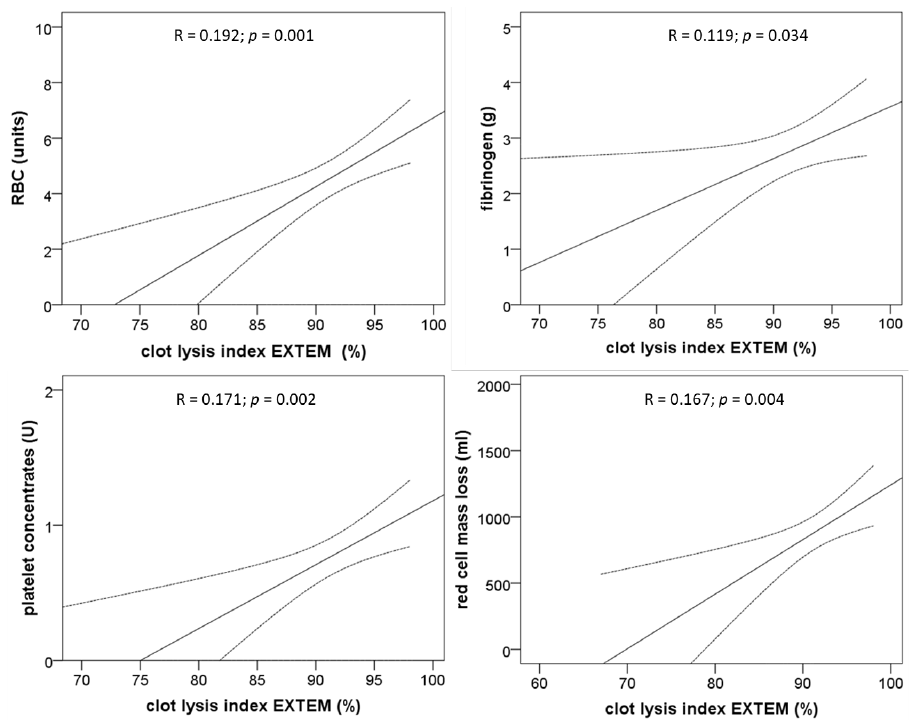
Figure 4. E ff ect of the clot lysis indices obtained with 4 di ff erent ROTEM ™ assays before the start Figure 4. Effect of the clot lysis indices obtained with 4 different ROTEM™ assays before the start of